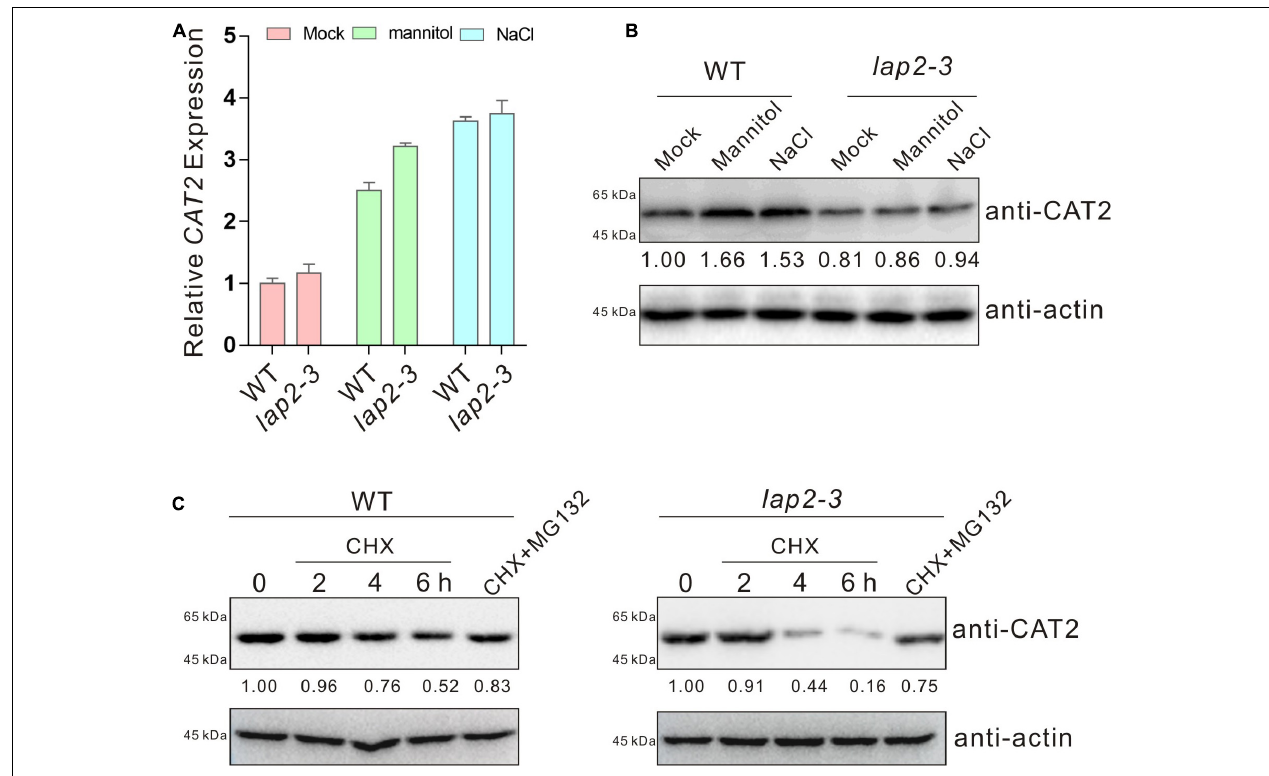
FIGURE 4 | Leucine aminopeptidase2 increases CAT2 protein stability. (A) The expression of CAT2 in 5-days-old wild-type and lap2-3 mutant seedlings treated with 250 mM mannitol or 125 mM NaCl for 5 days assayed by qRT-qPCR. The expression of CAT2 in the untreated wild type was set as 1. Data are means ( ± SD) of three biological replicates. (B) CAT2 protein accumulation in 5-days-old wild-type and lap2-3 mutant seedlings treated with 250 mM mannitol or 125 mM NaCl for 5 days using anti- CAT2 antibody. CAT2 protein level in the untreated wild type was set as 1. Actin was used as a loading control. (C) Immunoblot analysis of CAT2 protein accumulation in 5-days-old wild-type and lap2-3 mutant seedlings incubated with 50 µ M CHX for 2, 4, or 6 h or with 50 µ M CHX plus 100 µ M MG132 for 6 h using anti- CAT2 antibody. CAT2 protein level in the untreated wild type or lap2-3 mutant was set as 1. Actin was used as a loading control.